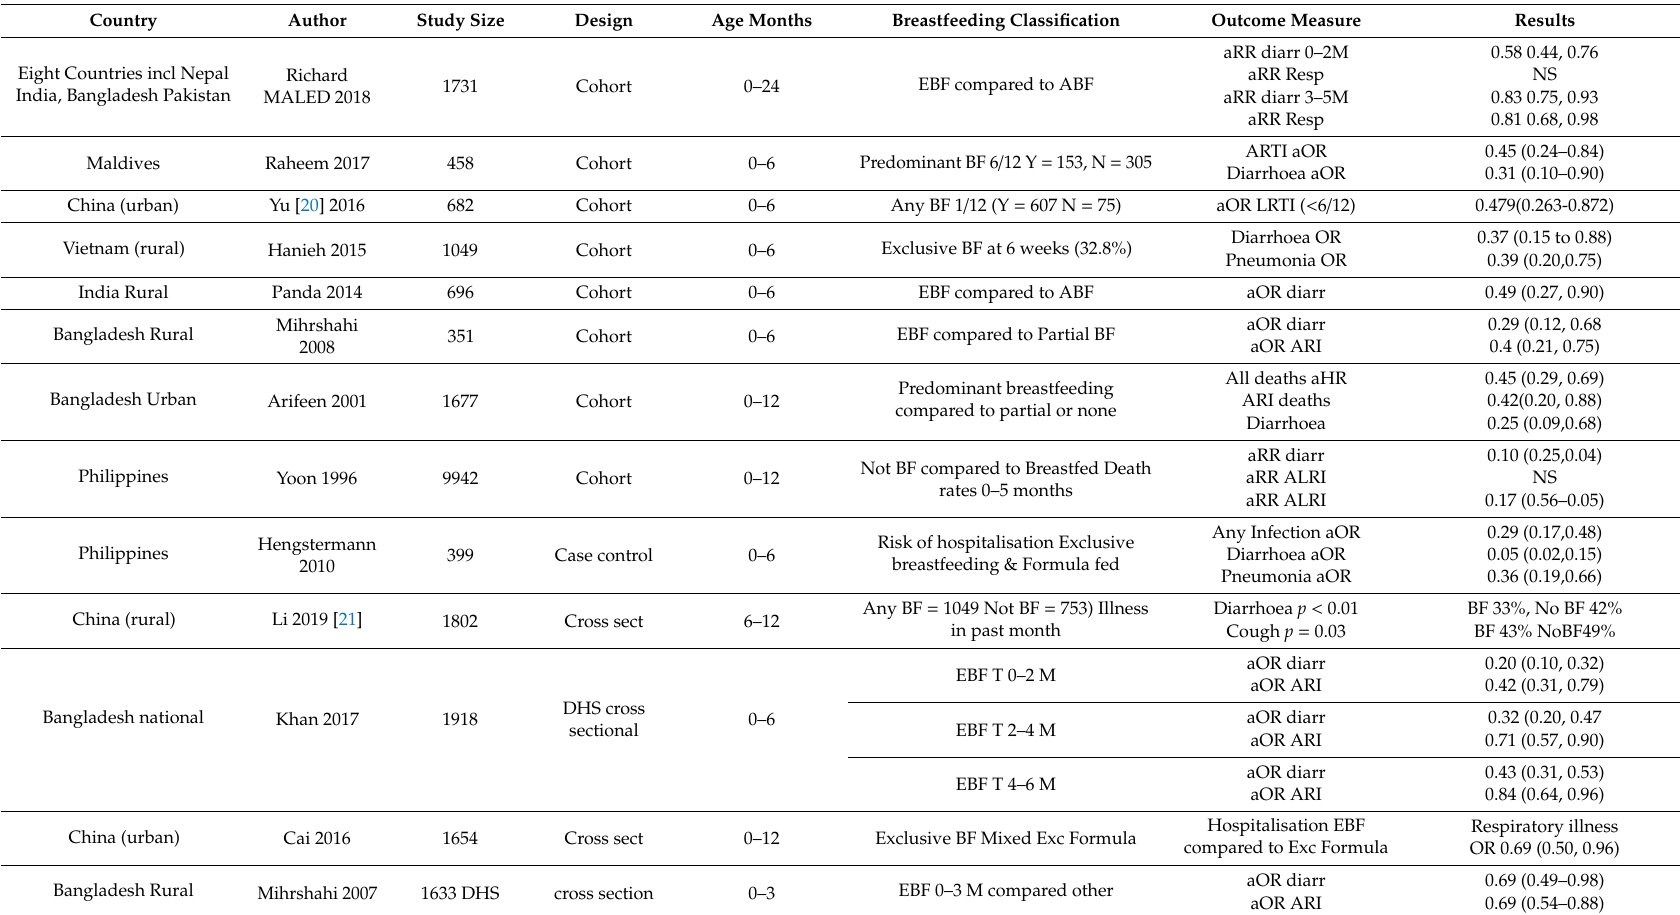
Table 1. Studies of Breastfeeding and Infection in Infants in